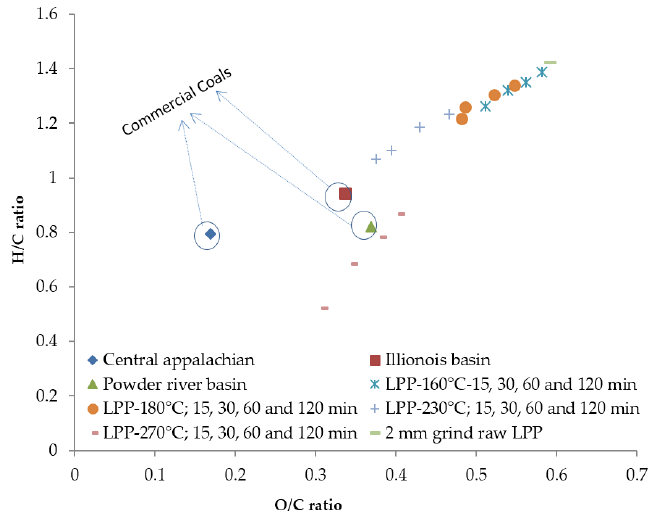
Figure 11. van Krevelen diagram for the raw, torrefied ground lodgepole pine and the commercial